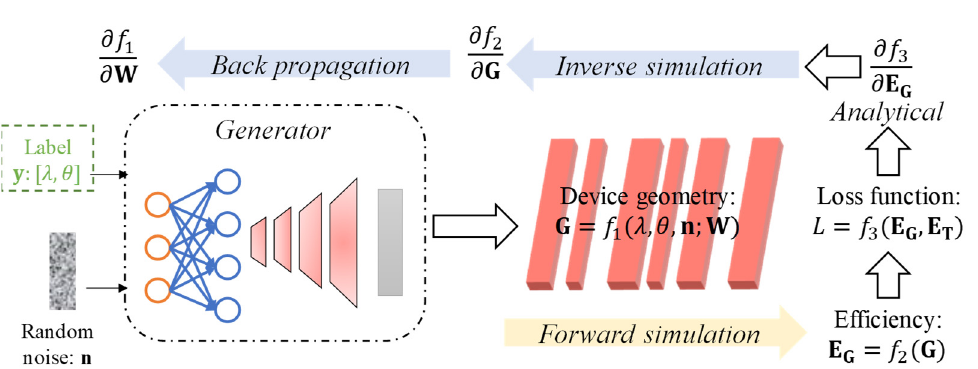
Figure 10. Merging DNN to optimization algorithms.